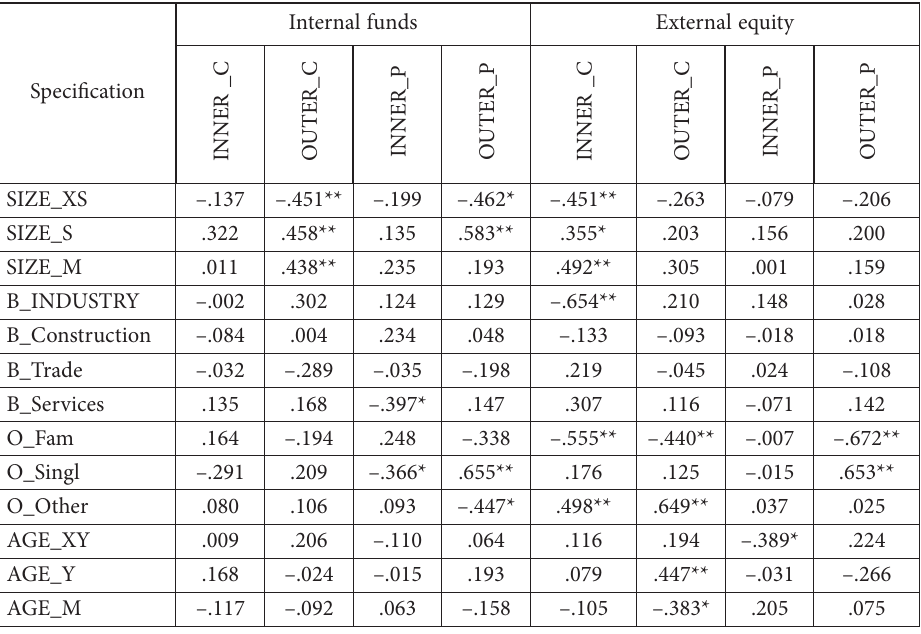
Table 5. The Pearson correlation coefficients for the relevance of equity financing and the proxies of SMEs characteristics